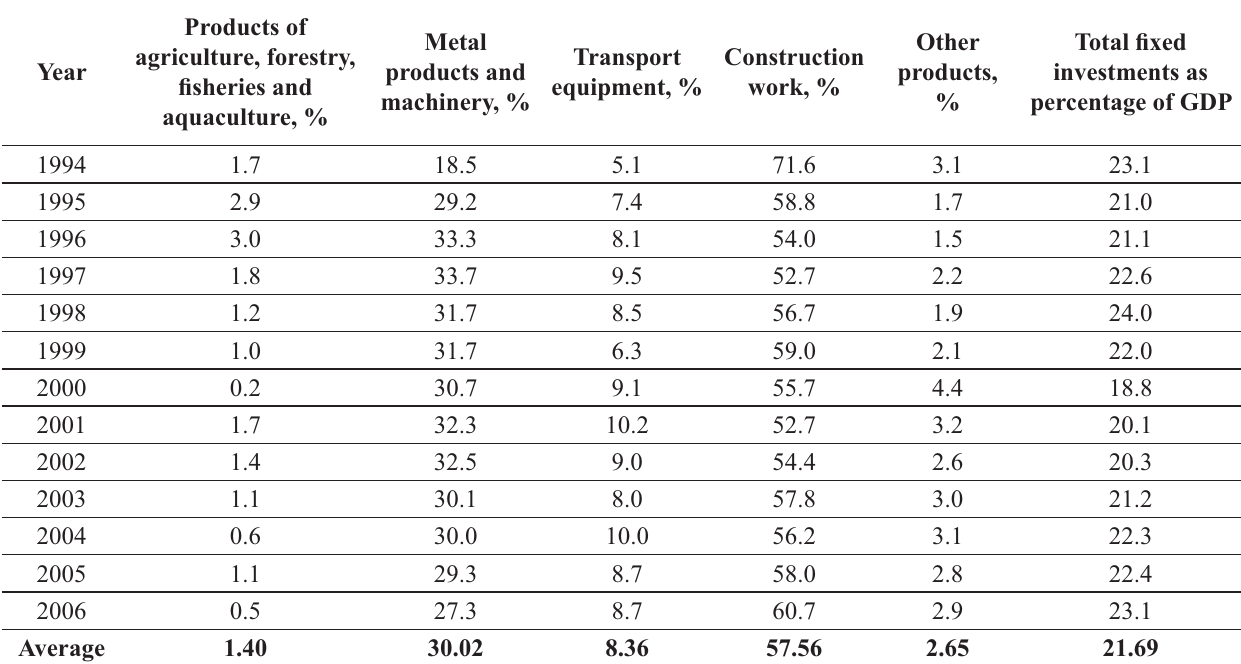
Table 2. Relationship between change of fi xed investments into particular activity and GDP growth in Lithuania